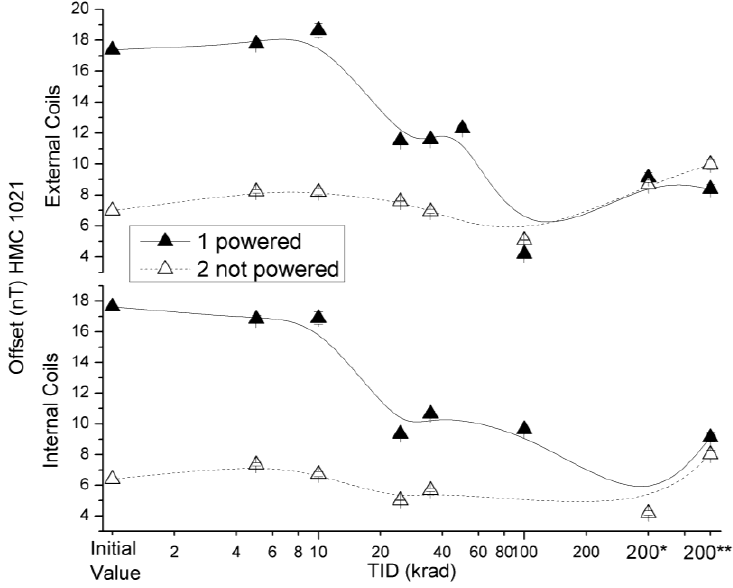
Figure 5. Measured offsets in external and internal coils configuration as a function of TID for powered and non-powered HMC 1021